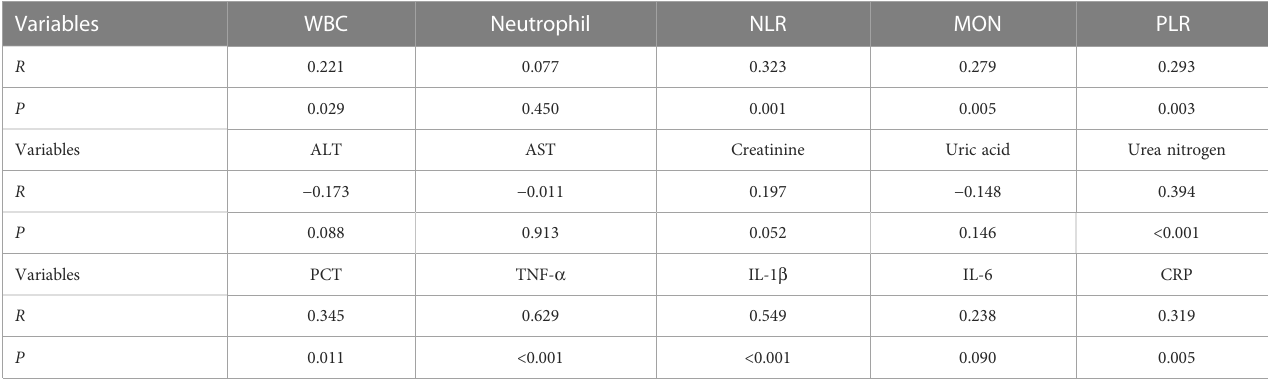
TABLE 3 Correlations between serum C3a and clinical parameters.